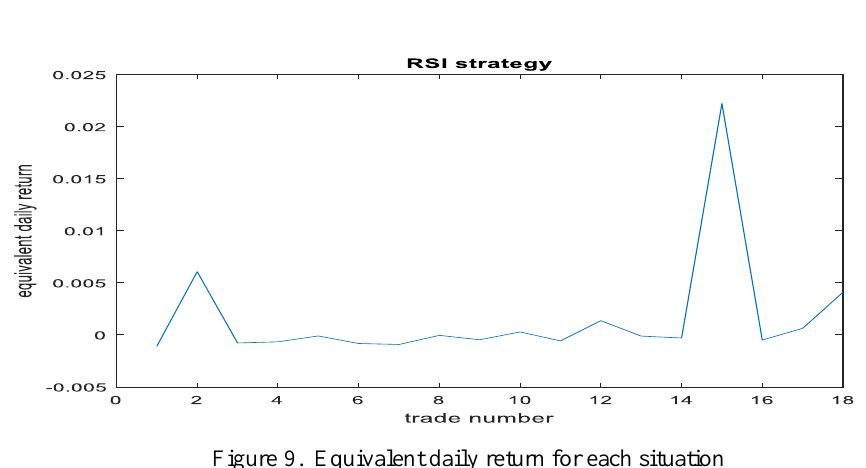
Figure 9. Equivalent daily return for each situation